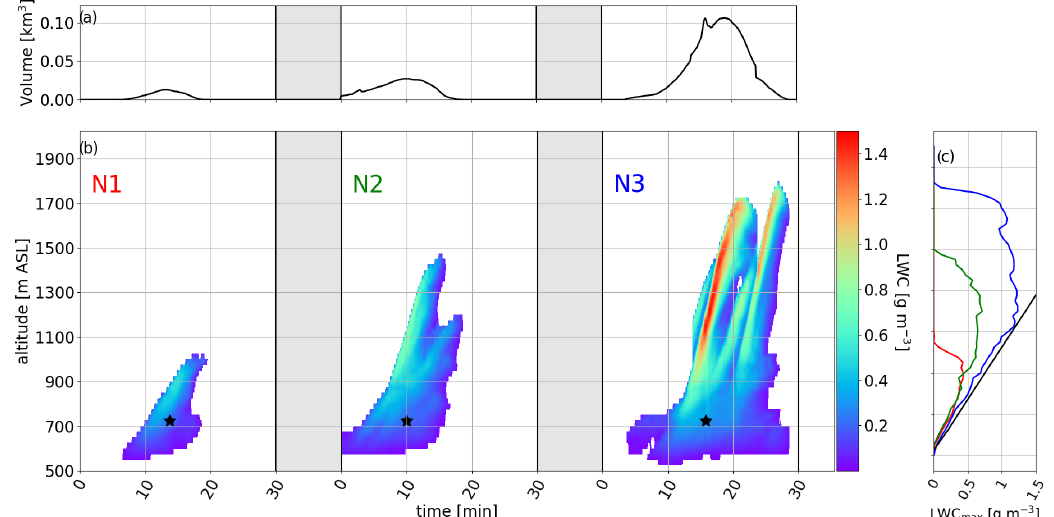
Figure 5. Life cycle of three clouds N1, N2, and N3 for (a) their volume and (b) their LWC. The black star represents altitude and time for static cloud exploration. (c) The comparison between the maximum LWC for each vertical level during each cloud life cycle and the limit of pseudo-adiabatic LWC (black line).